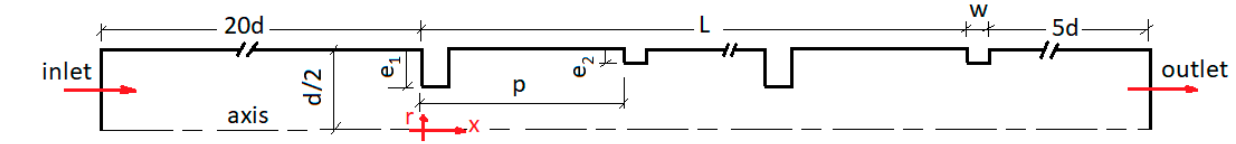
Figure 2. Schematic diagram of the computational domain.